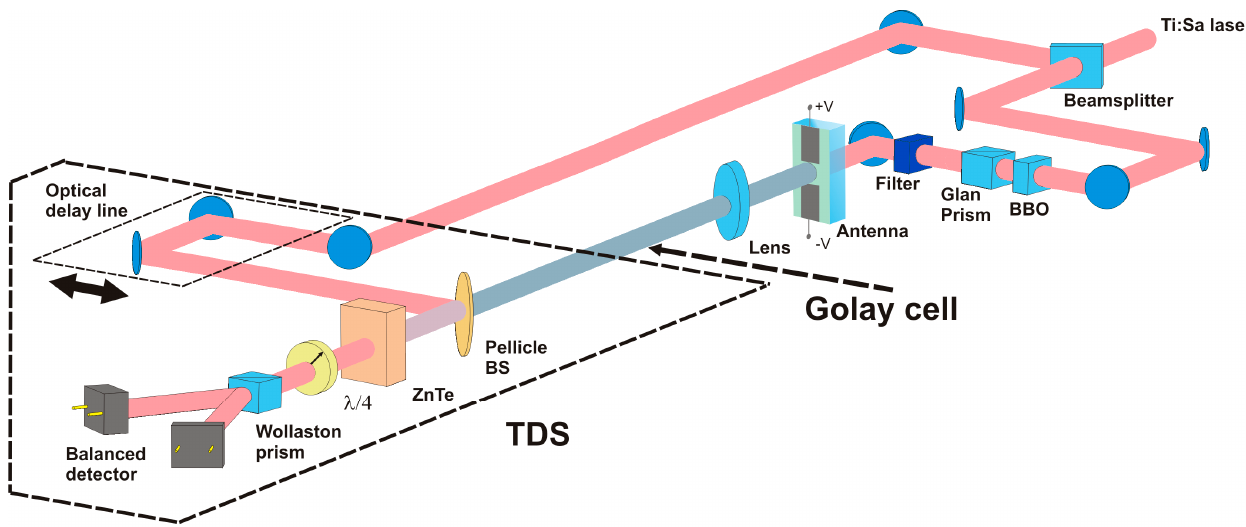
Figure 2. Experimental setup for the generation and detection of terahertz (THz) pulses from a large-aperture photoconductive antenna.